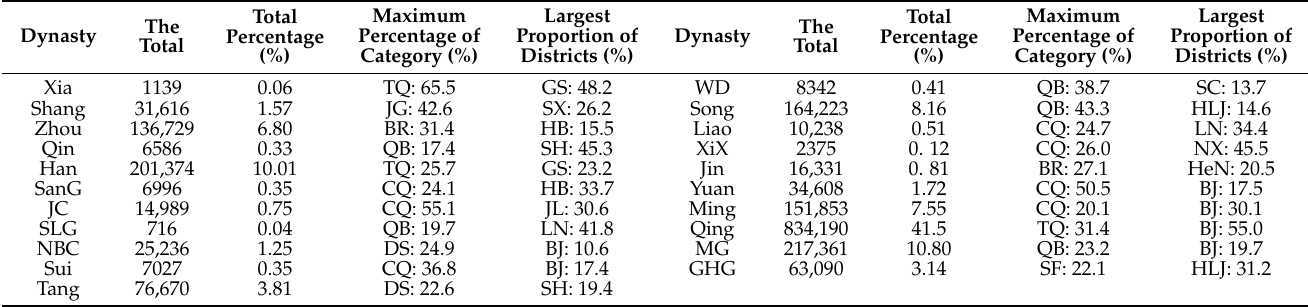
Table 1. Basic distribution of cultural relics in different